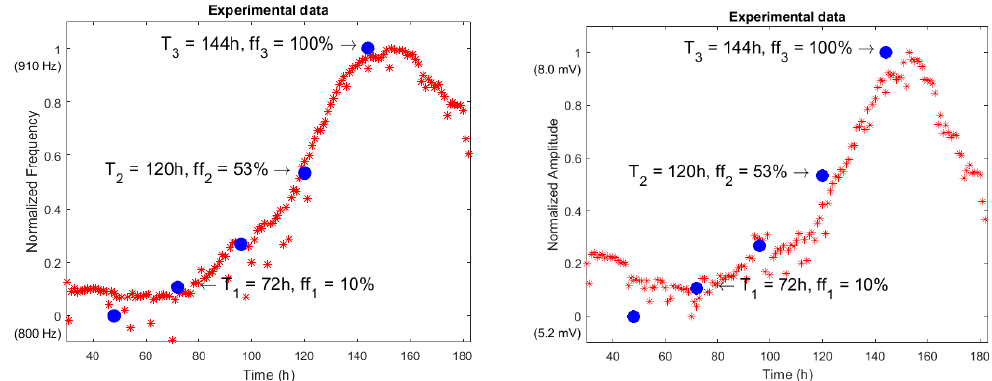
Figure 10. Normalized frequency ( left ) and amplitude ( right ) evolution over time (hours) for a selected well. Blue points have been obtained at set time points (T N ) from a traditional assay using Petri plates (W6, 2500 N2A seeded cells in t = 0).